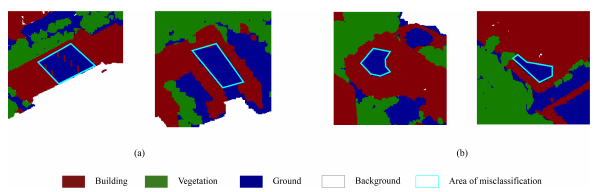
Figure 8. Misclassification cases in the Shenzhen dataset. (a) Faults due to edge interruption. (b) Faults due to untrained object